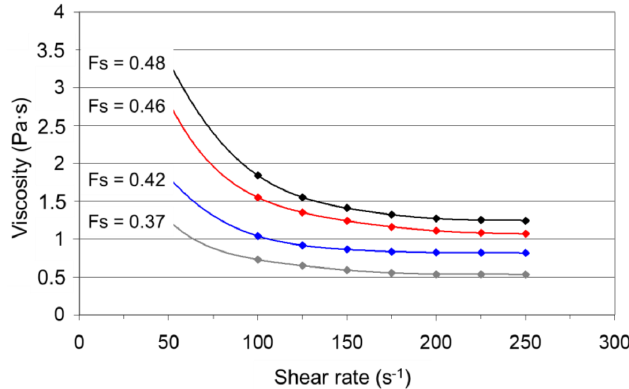
Figure 3. Example of plot of viscosity measurements in isothermal conditions from shear rate experiments for A356 alloy at various solid fractions showing the typical shear thinning behavior of SSM